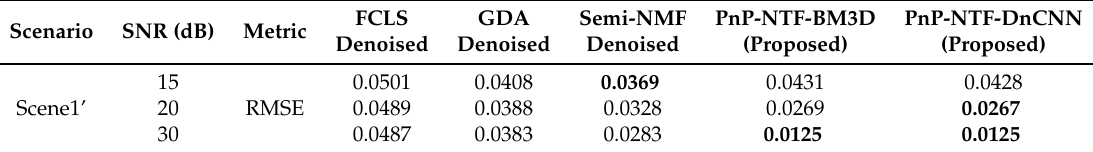
Table 4. Evaluation result of denoised abundance in ‘Scene1’ with different SNRs.